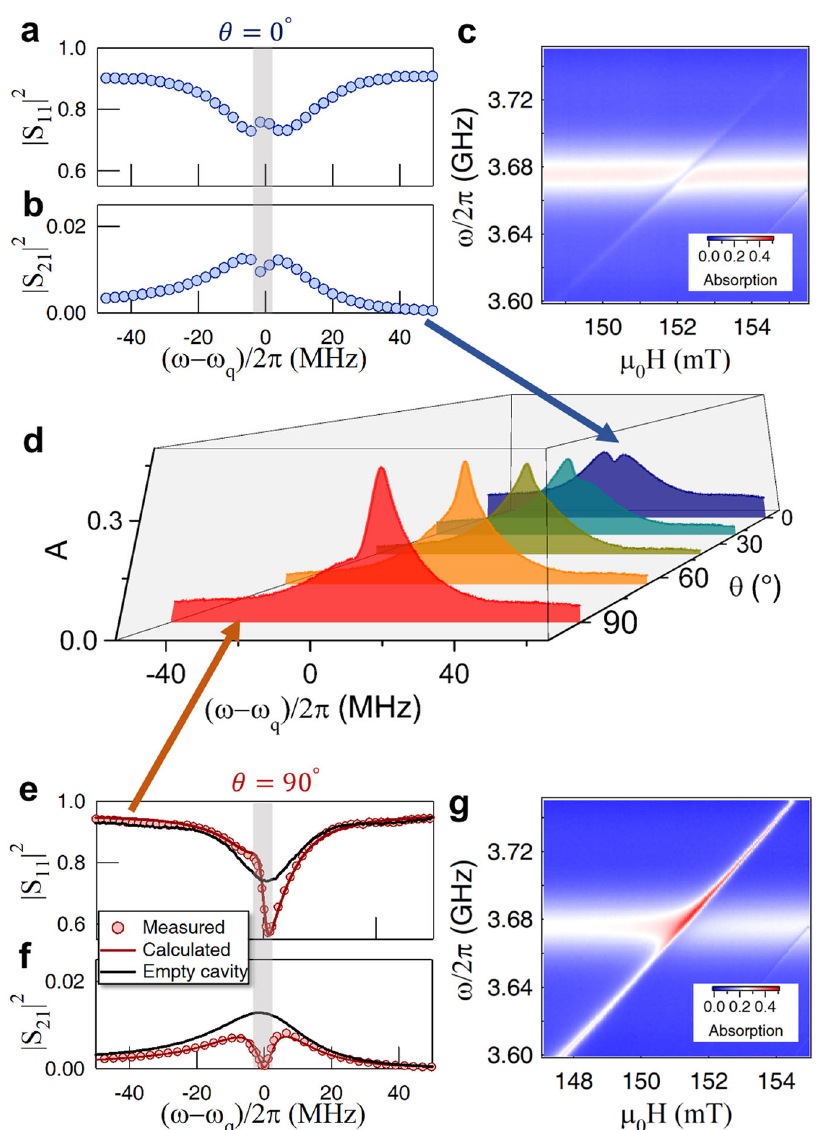
Fig. 3 Absorption enhancement. At θ = 0 ∘ , corresponding to conventional MIT dynamics, the squared amplitudes of the re fl ection ( ∣ S 11 ∣ 2 ) enhancement and transmission ( ∣ S 21 ∣ 2 ) suppression at zero detuning are plotted in ( a ) and ( b ). Measured absorption spectra at different bias fi elds are plotted in ( c ). By tuning θ , the measured absorption spectra at 5 different angles are plotted in ( d ). Typically, at θ = 90 ∘ , both squared amplitudes of the re fl ection ( e ) and transmission ( f ) are suppressed relative to the empty cavity (black solid lines). Red solid lines in ( e ) and ( f ) indicate the calculated results. Absorption spectra measured at different bias magnetic fi elds are plotted in ( g ), which shows an evident absorption enhancement (the red